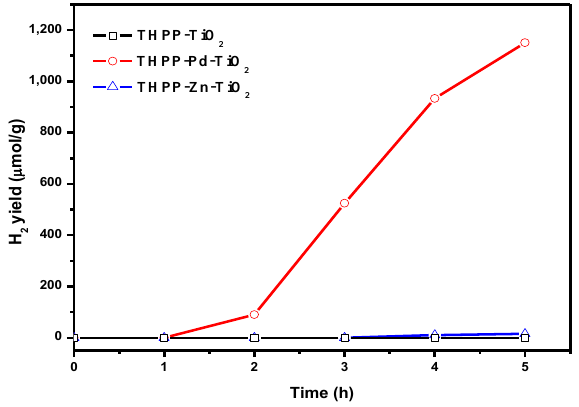
Figure 7. H 2 production curves of THPP-TiO 2 , THPP-Pd-TiO 2 , and THPP-Zn-TiO 2 in an aqueous solution of 10% TEOA under visible-light irradiation ( λ > 420 nm).